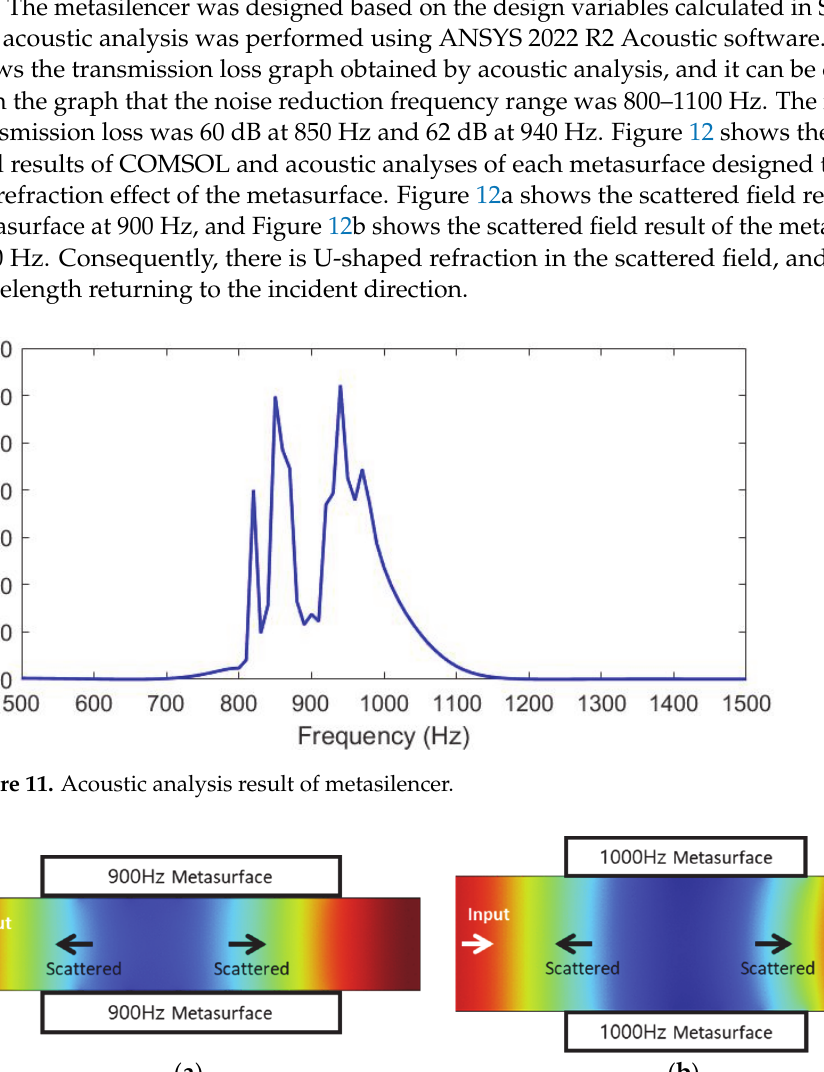
Figure 10. Schematic of HVAC test setup.